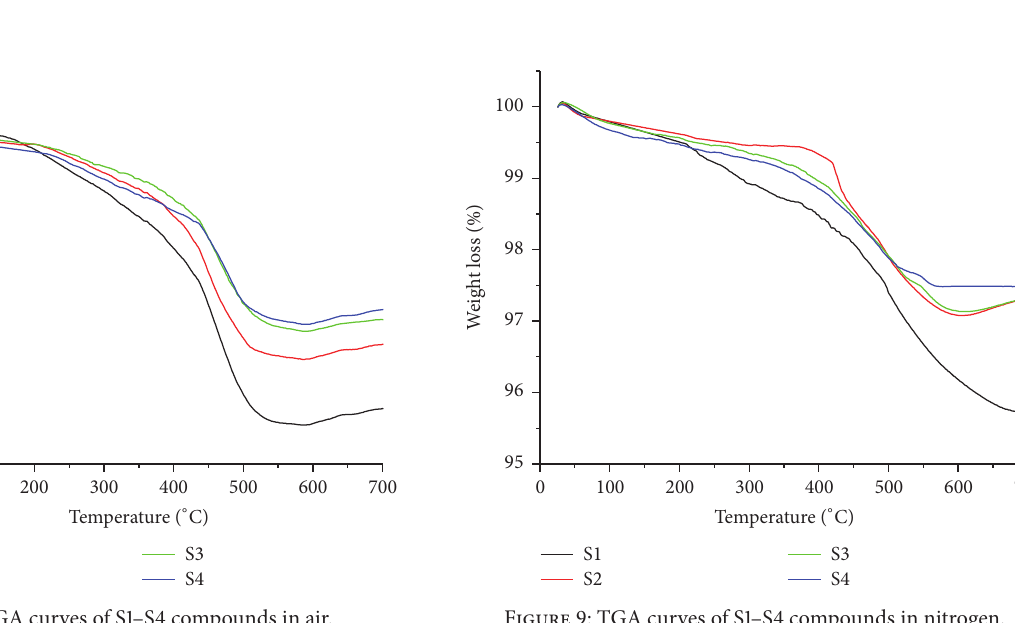
observed in the TGA curves. This peak is attributed to the combustion of the organic material yielding basically CO 2 , P 2 O 5 , and H 2 O. Almost no weight loss is observed above 600 ∘ C, suggesting the formation of crystalline SnO 2 as a decomposition product. Tin oxides are stable between 500 ∘ C and 800 ∘